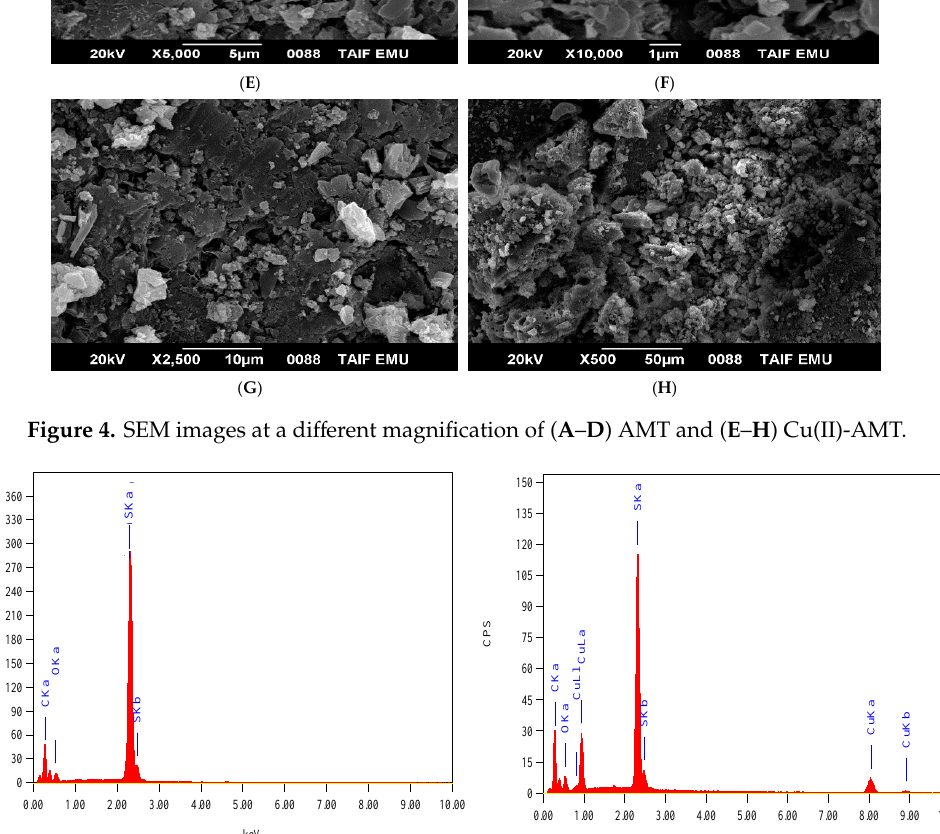
Figure 5. EDX spectra of ( A ) AMT and ( B ) [Cu(L)(NO 3 )(H 2 O) 2 ] . H 2 O. Table 2. The elemental analysis of AMT ligand and Cu(II)-AMT complex. Weight % Weight % Element Calculated Found